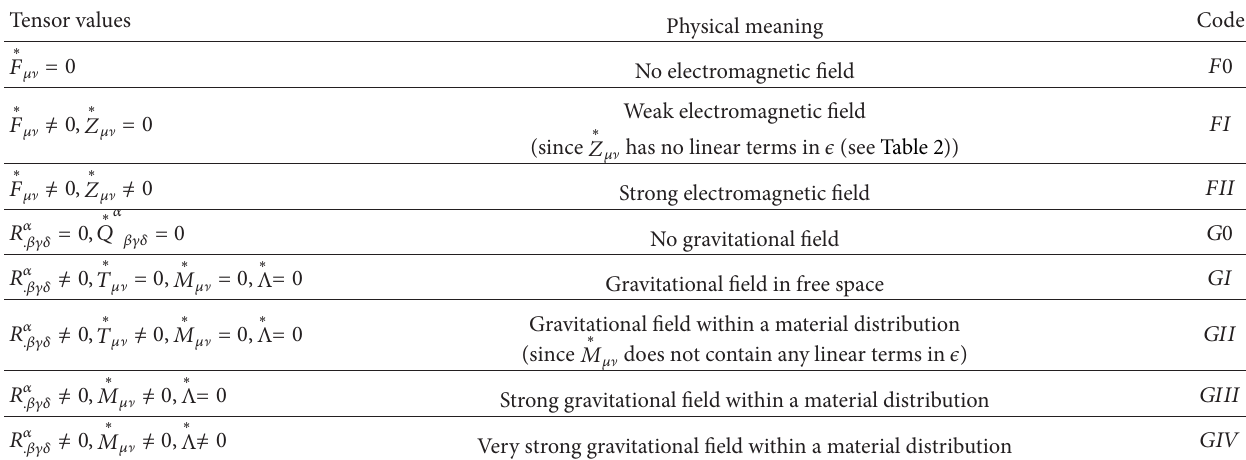
Table 3: Type analysis.